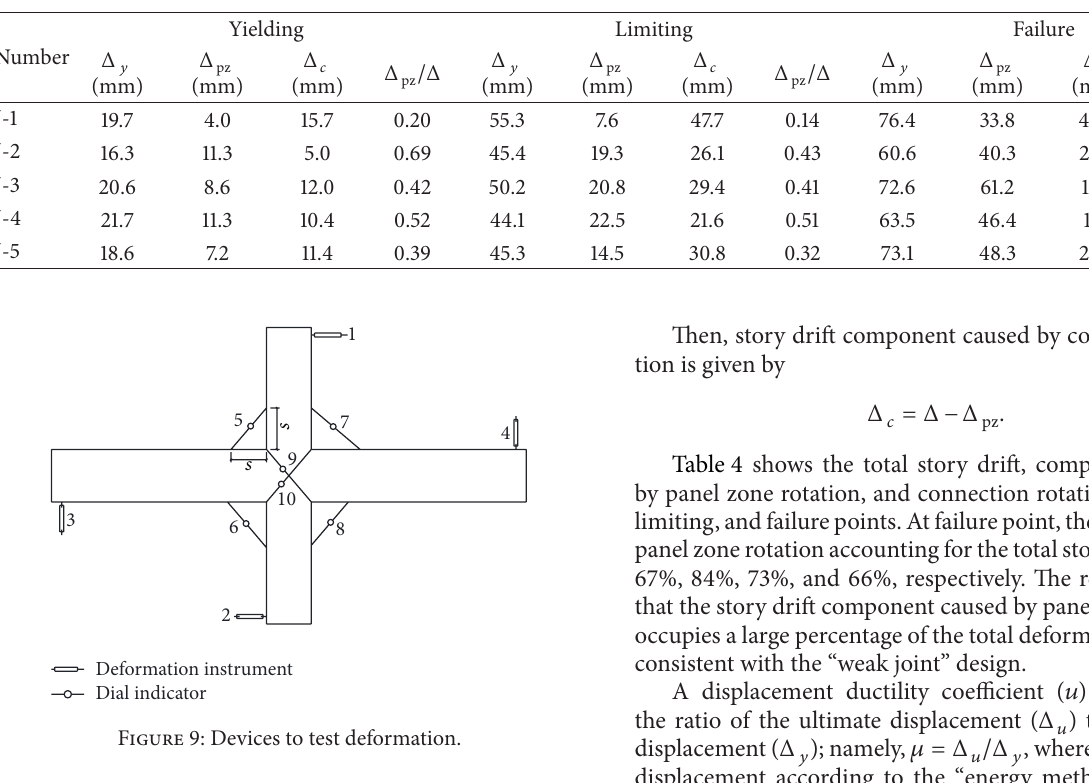
Table 4: Story drift analysis at yielding, limiting, and failure point.